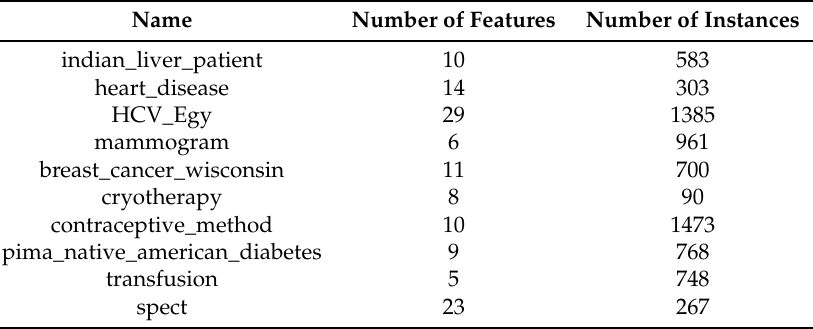
Table 1. Classification datasets.